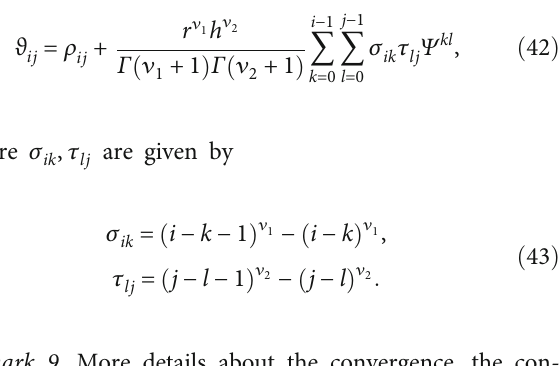
Figure 2: The solution ϑ = ð ϑ respectively. The norm k ϑ k = 3 : 1271